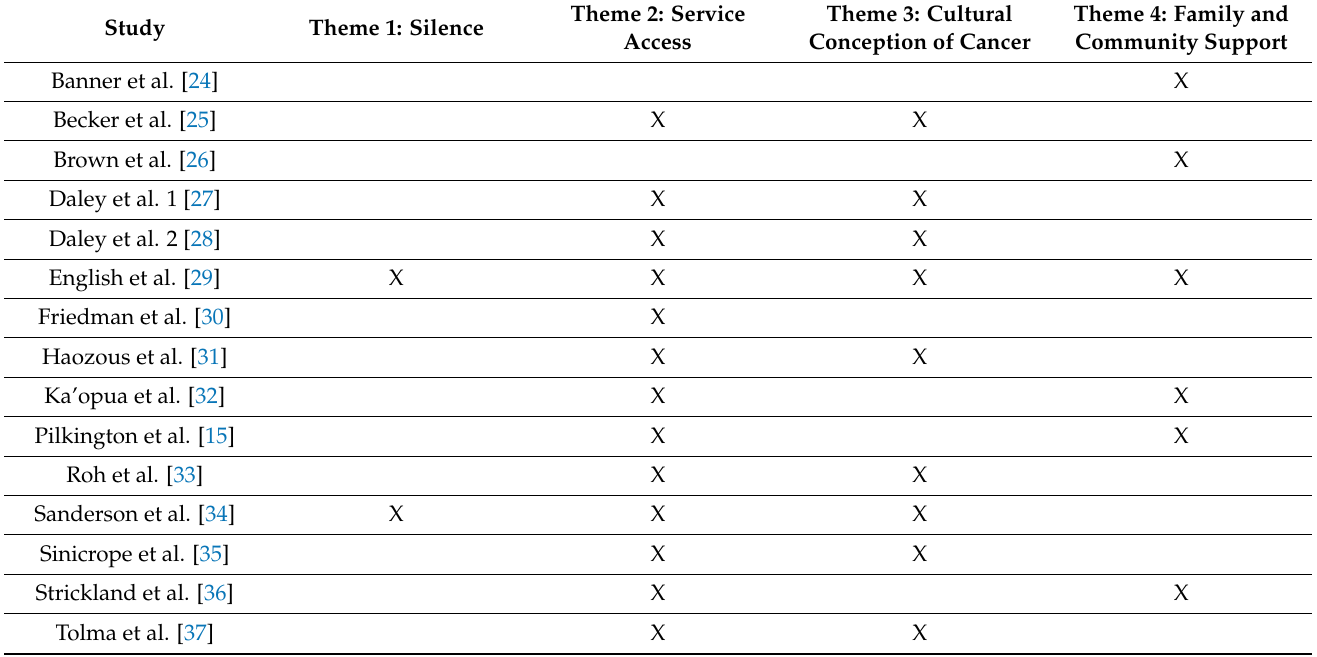
Table 3. Summary of themes emerging from the